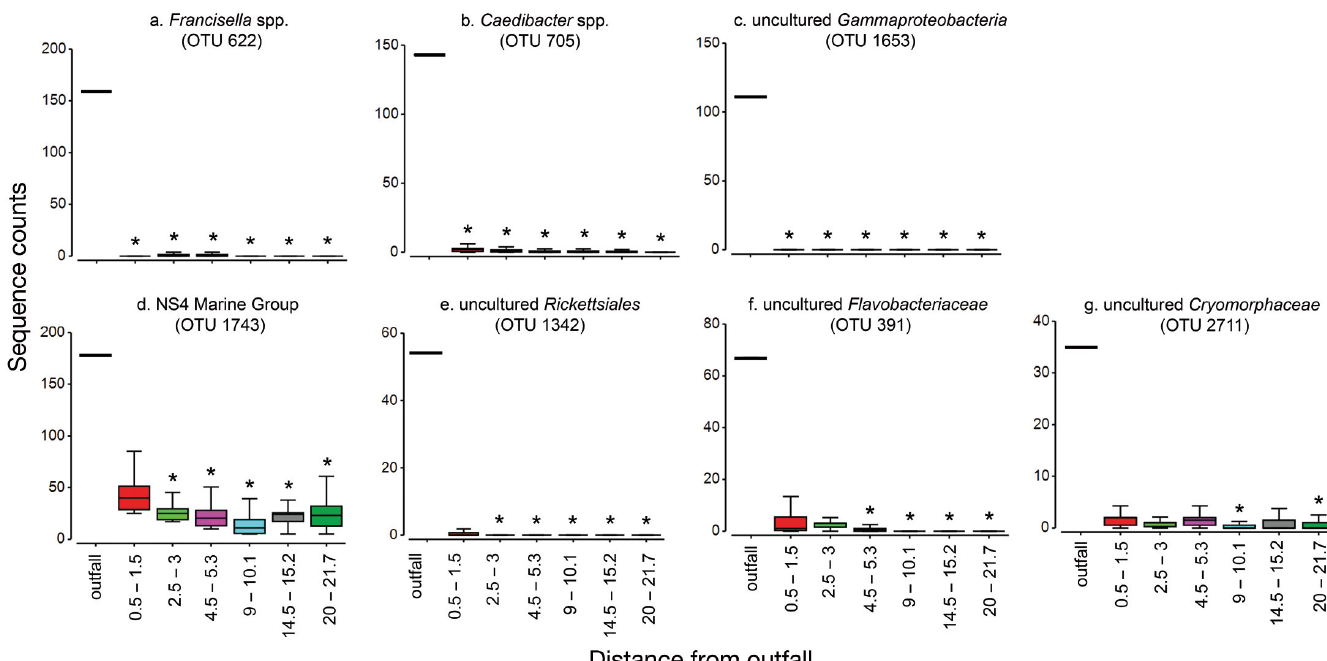
Fig. 6. Box-and-whisker plots of sequence counts for the 7 operational taxonomic units (OTUs) that were significantly enriched at the outfall site: (a) Francisella spp., (b) Caedibacter spp., (c) uncultured Gammaproteobacteria , (d) NS4 Marine Group, (e) uncultured Rickettsiales , (f) uncultured Flavobacteriaceae , and (g) uncultured Cryomorphaceae . *Distance groups with signif- icantly depleted sequence counts compared to sequence counts at the outfall (p < 0.05). The outfall includes 1 sample (indi- cated by single line) and the other distance groups include 3−5 samples. In each plot, middle line denotes median, box outlines upper and lower 25% quartiles, and whiskers denote maximum and minimum